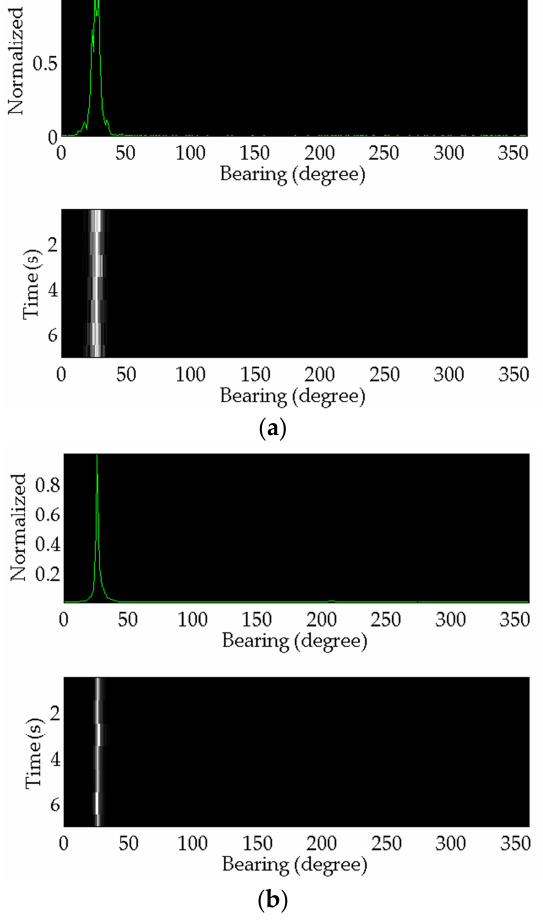
Figure 12. The azimuth angle estimation results of the acoustic source ship. ( a ) The result of the conventional method; ( b ) The result of the proposed method.